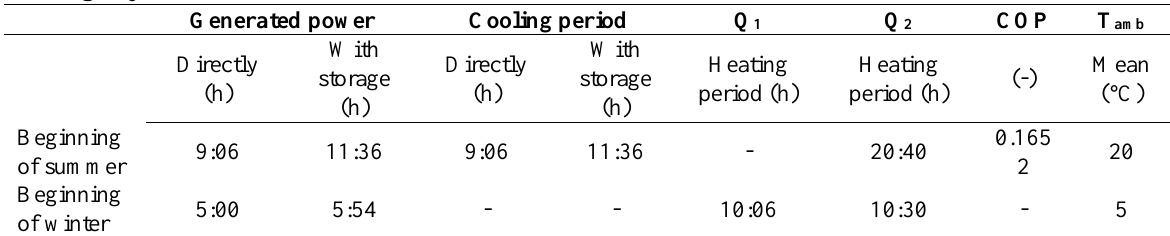
Table 6. Generation hours of power, cooling, and heating in a direct way and along with storage